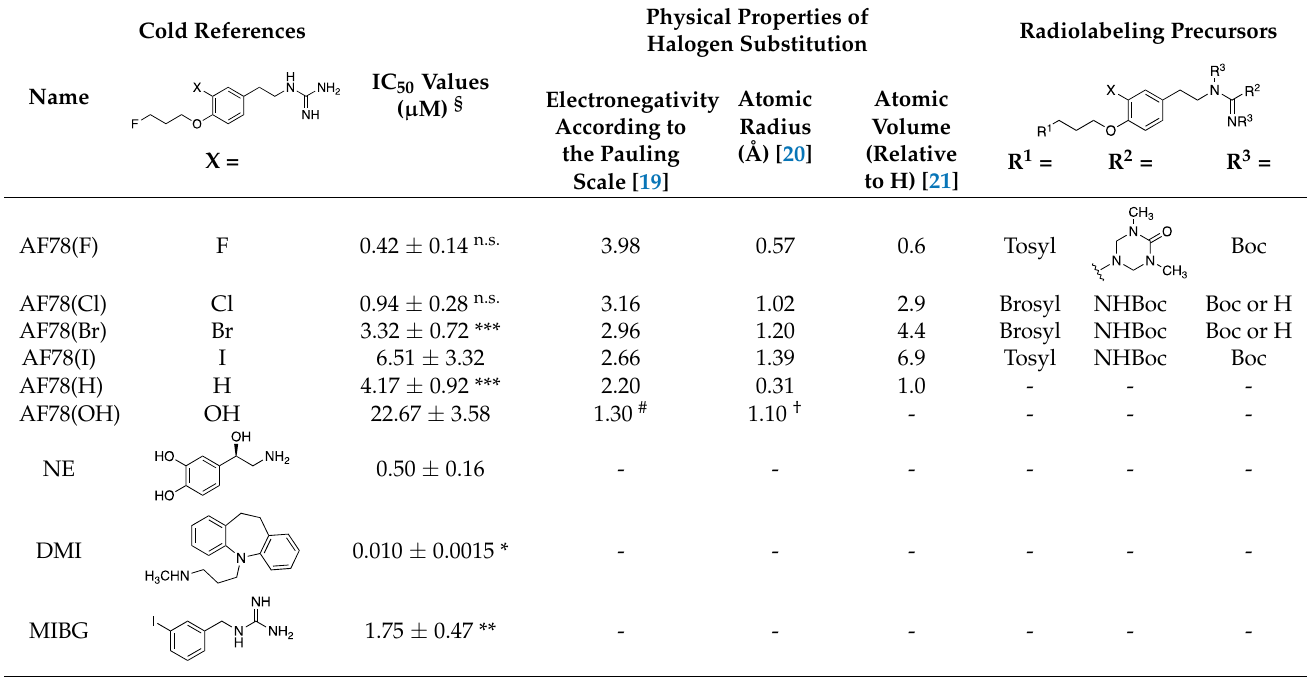
Table 1. Chemical structures, competitive cellular uptake activities and physical properties of the reference compounds, cold references and corresponding radiolabeling precursors.